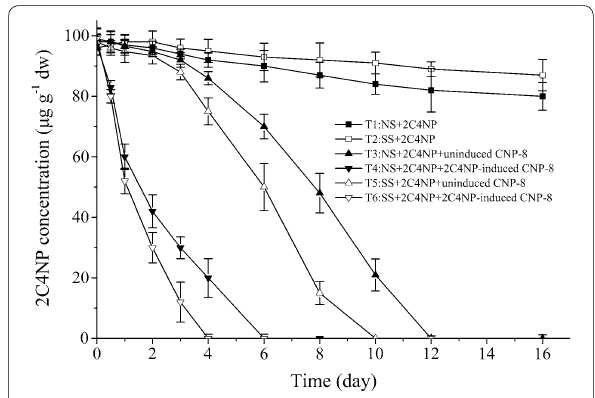
Fig. 5 Biodegradation of 2C4NP by strain CNP-8 in soil microcosms. The experiments were performed in triplicate, and values are mean standard deviation (n 3). NS native soil, SS sterilized ± =